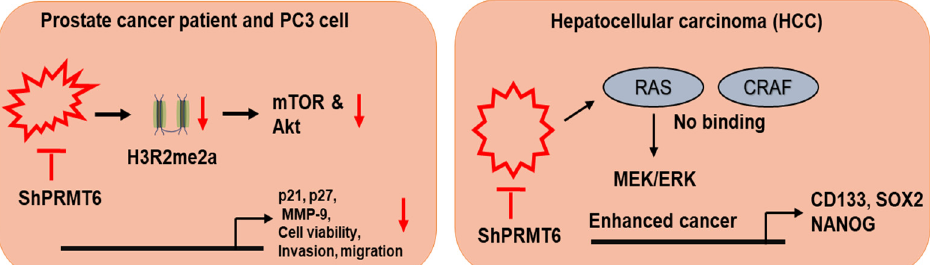
Figure 5. Role of PRMT5 in post translation modification. PRMT-mediated epigenetic gene activation/repression. PRMT6 knockdown in PC-3 cells displayed decrease in malignant phenotype, increasing apoptosis and decreasing cell viability, migration and invasion. PRMT6 silencing was associated with decreased H3R2me2a levels. Interaction of PRMT6 with CRAF on arginine 100, which decreased its RAS binding potential and altered its downstream MEK/ERK signaling.